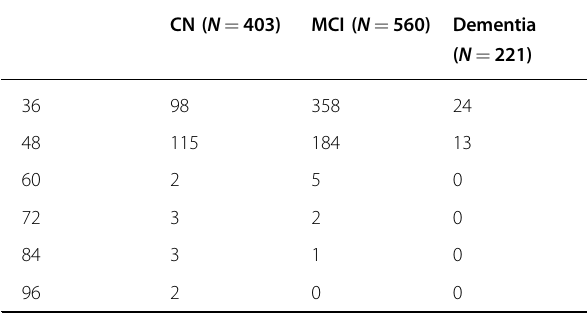
Table 1 Baseline participant